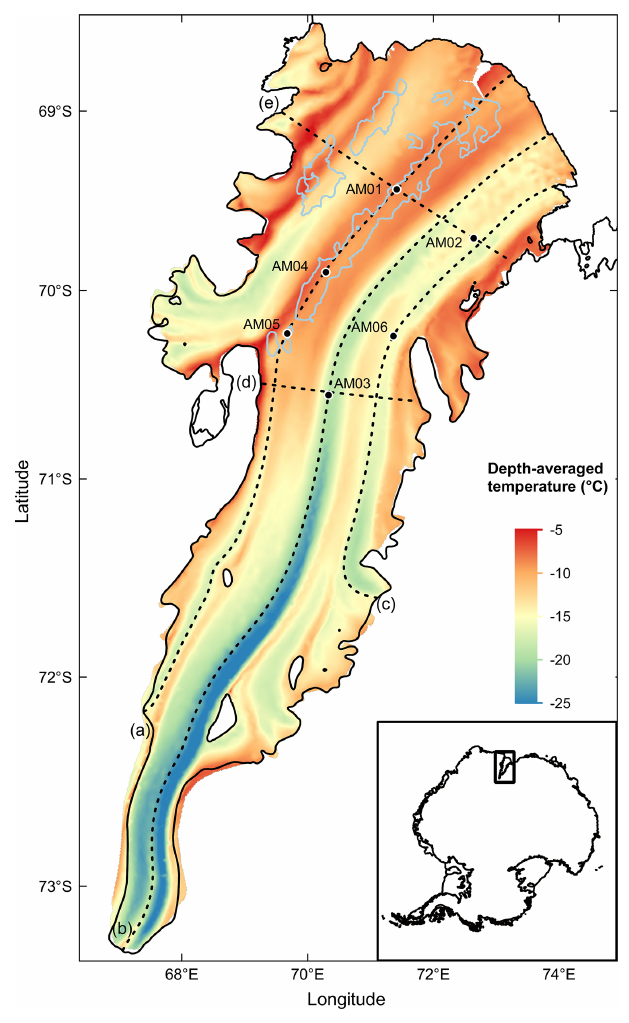
Figure 8. Depth-averaged temperature distribution of the AIS from the 3-D simulations with BMB_CAL. Three flowlines, derived from simulated velocity field, and two crossing lines are marked with dashed lines. Marked letters (a–e) correspond to the sequence of cross-sections in Fig. 9. Marine ice band with estimated thickness greater than 100m is shown with the light blue contours (Fricker et al., 2001). Inset shows the location of the Amery Ice Shelf in East